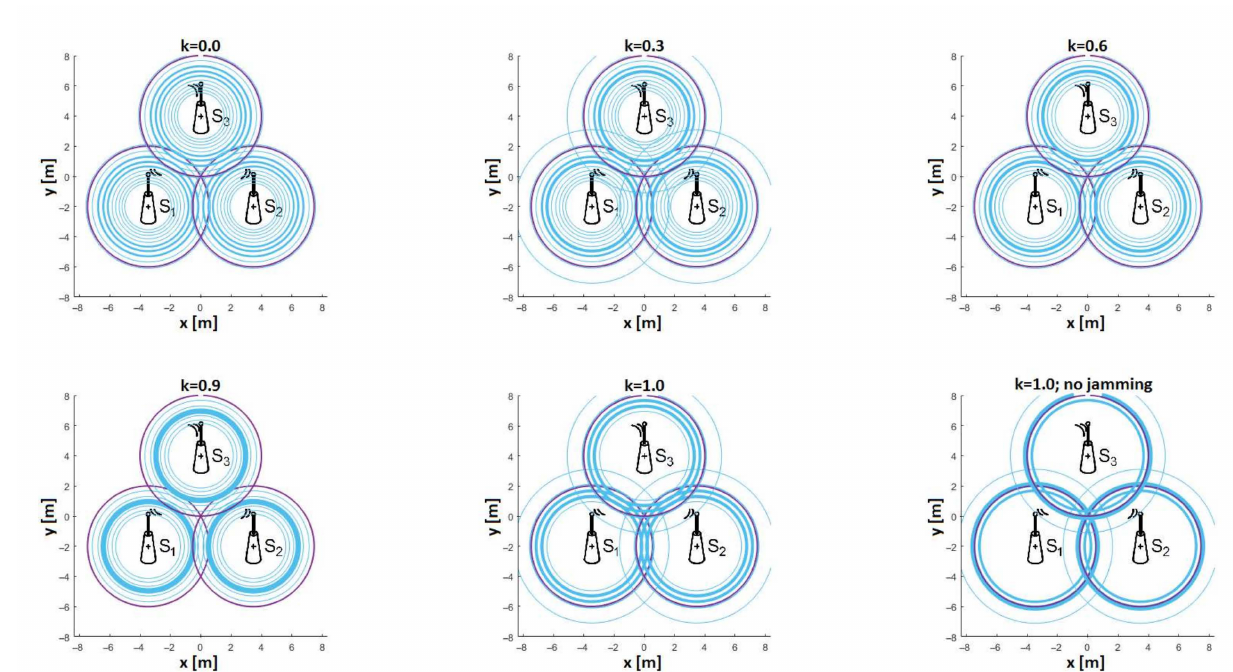
Figure 22. Visualization of the trilateration for the same distance estimation values for all radio sensors.